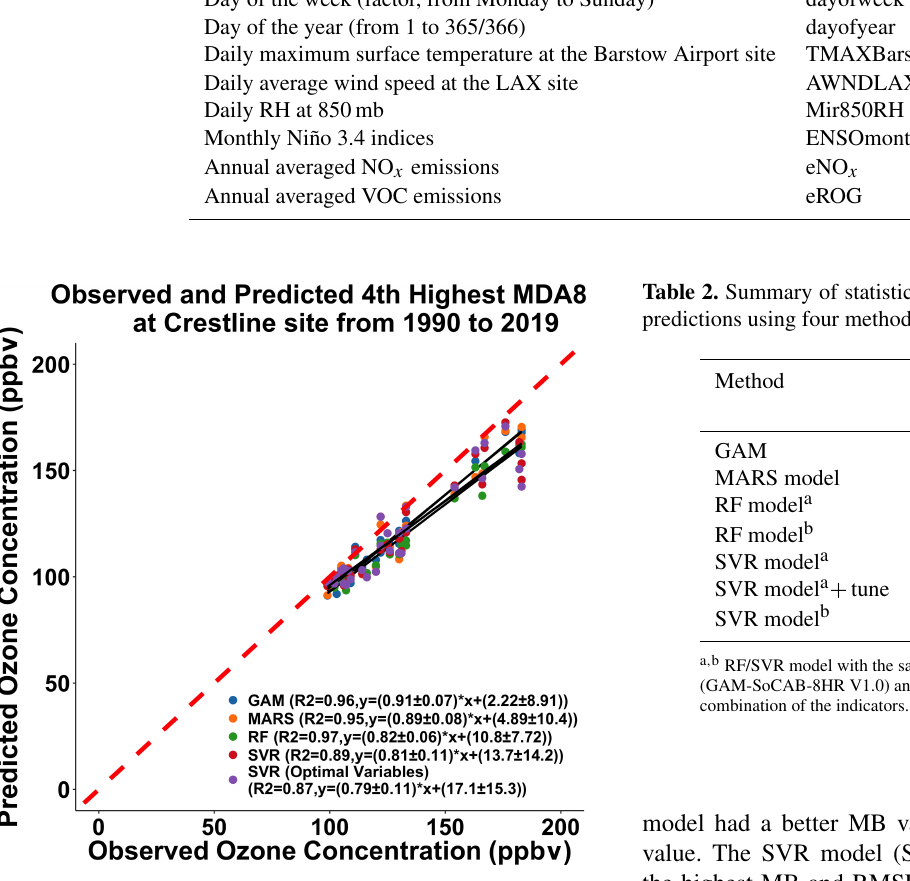
Figure 3. Comparison between the fourth highest observed and pre- dicted MDA8 ozone concentrations using the GAM model built for the top 30 MDA8 ozone days at the Crestline site using the GAM- SoCAB-8HR V1.0 model (blue), MARS-SoCAB-8HR V1.0 model (orange), RF-SoCAB-8HR V1.0 model (green), SVR-SoCAB-8HR V1.0 model (red) and SVRoptimal-SoCAB-8HR V1.0 model (pur- ple).